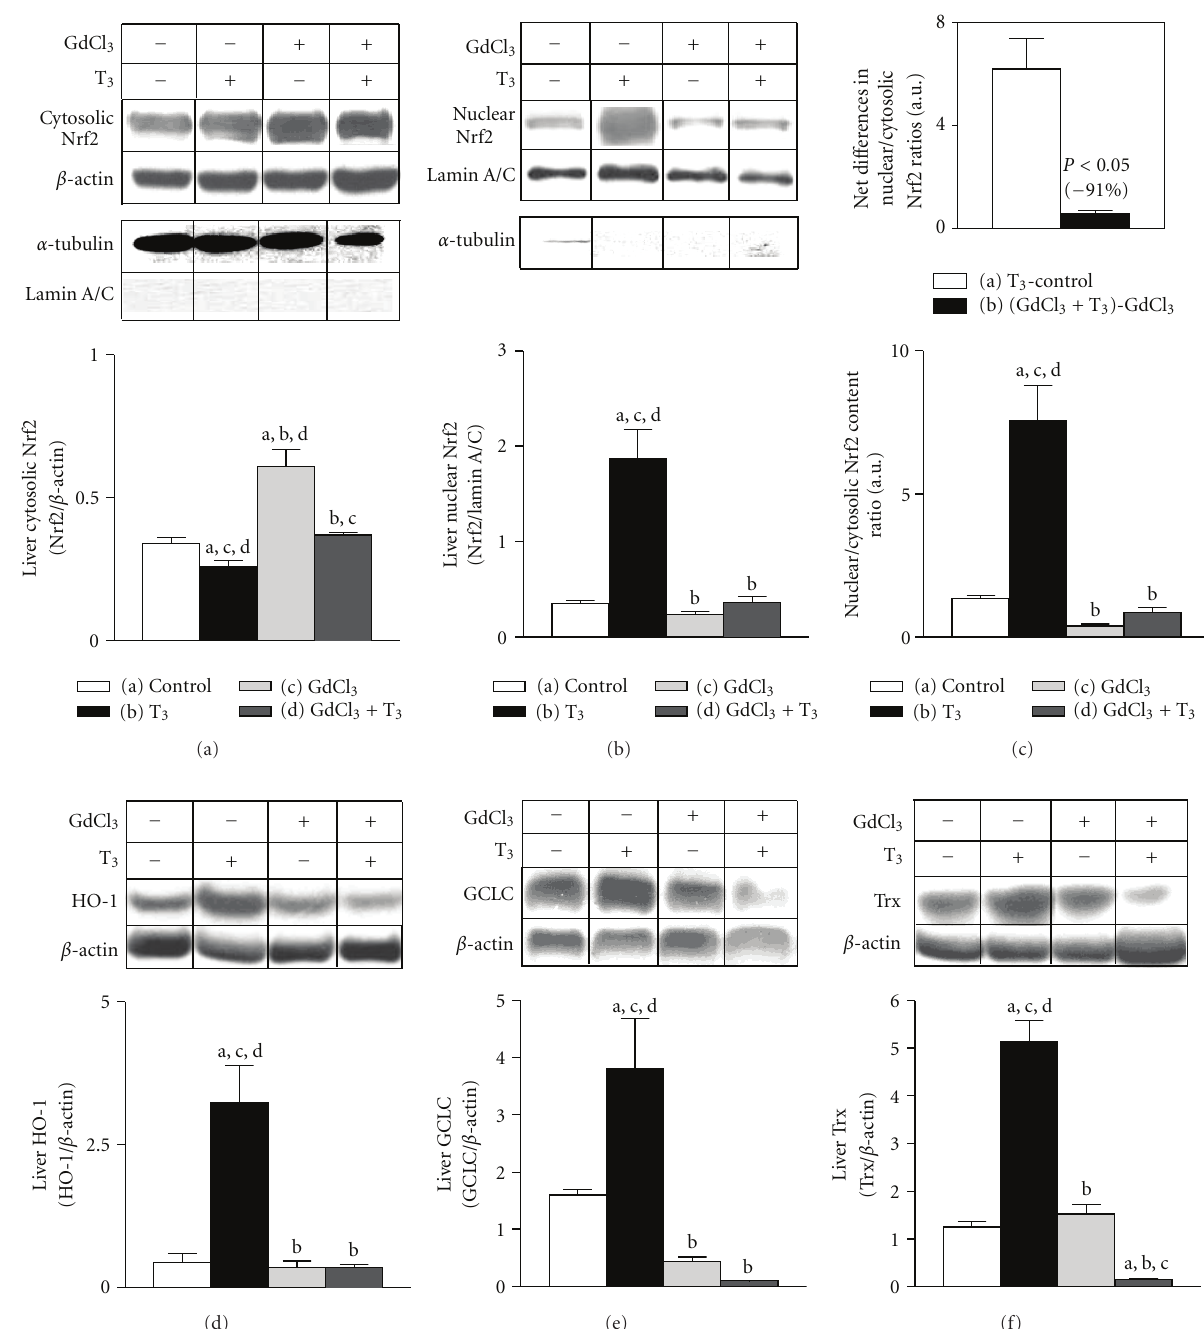
Figure 2: Gadolinium chloride (GdCl 3 ) administration is associated with suppression of T 3 -induced activation of liver Nrf2 signaling. Determinations were performed at 2h after T 3 administration in rats pretreated with GdCl 3 for 72 h. (a) Levels of cytosolic Nrf2 protein (68kDa), β -actin (43 kDa), α -tubulin (52 kDa), and lamin A/C (65kDa); (b) levels of nuclear Nrf2 protein, lamin A/C, and α -tubulin; (c) nuclear/cytosolic Nrf2 content ratios and net e ff ects of T 3 and GdCl 3 treatments ( inset ); (d) levels of heme oxygenase 1 (HO-1) protein (33kDa); (e) levels of catalytic subunit of glutamate cysteine ligase (GCLC) protein (73kDa); (f) levels of thioredoxin (Trx) protein (12 kDa). Values shown represent means ± SEM for 3 to 6 rats per experimental group. Significance ( P < 0 . 05; two-way ANOVA and the Newman- Keuls’ test) is indicated by the letters identifying each experimental group. Significance in the inset of (c) was calculated by Student’s t -test for unpaired